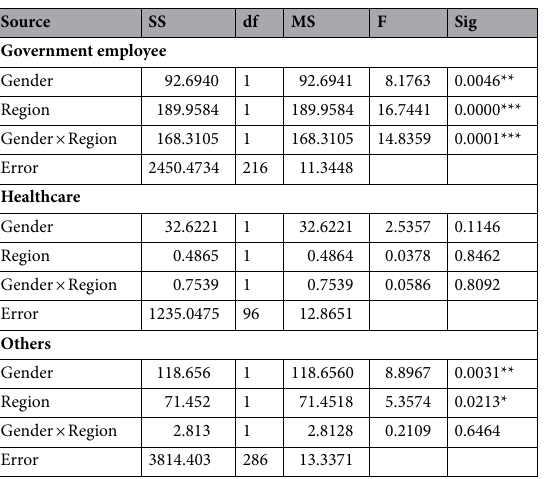
Table 12. Simple interaction effect of different occupations and avoiding human contact. * p < .05, ** p < .01, *** p < .001.